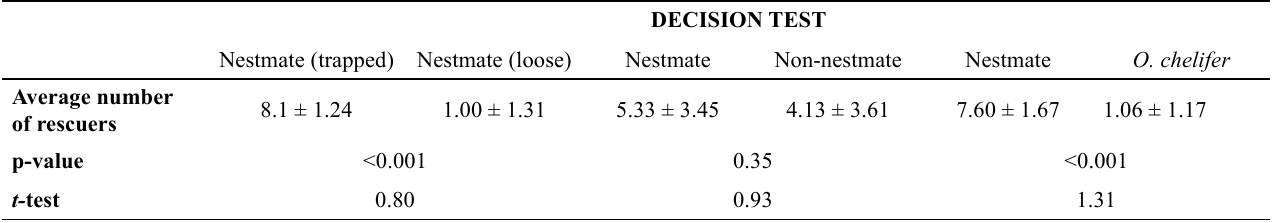
with a nestmate, compared to a chamber with a non-nestmate The behaviors suggested that some kind of rescue was only (Table 3). The behaviors exhibited by the rescuers when they arrived at the trapping chamber are described in Table 4. Table 3 . Average numbers of rescue ants present in the trapping chambers when an ant was trapped on one side of the connector tube.